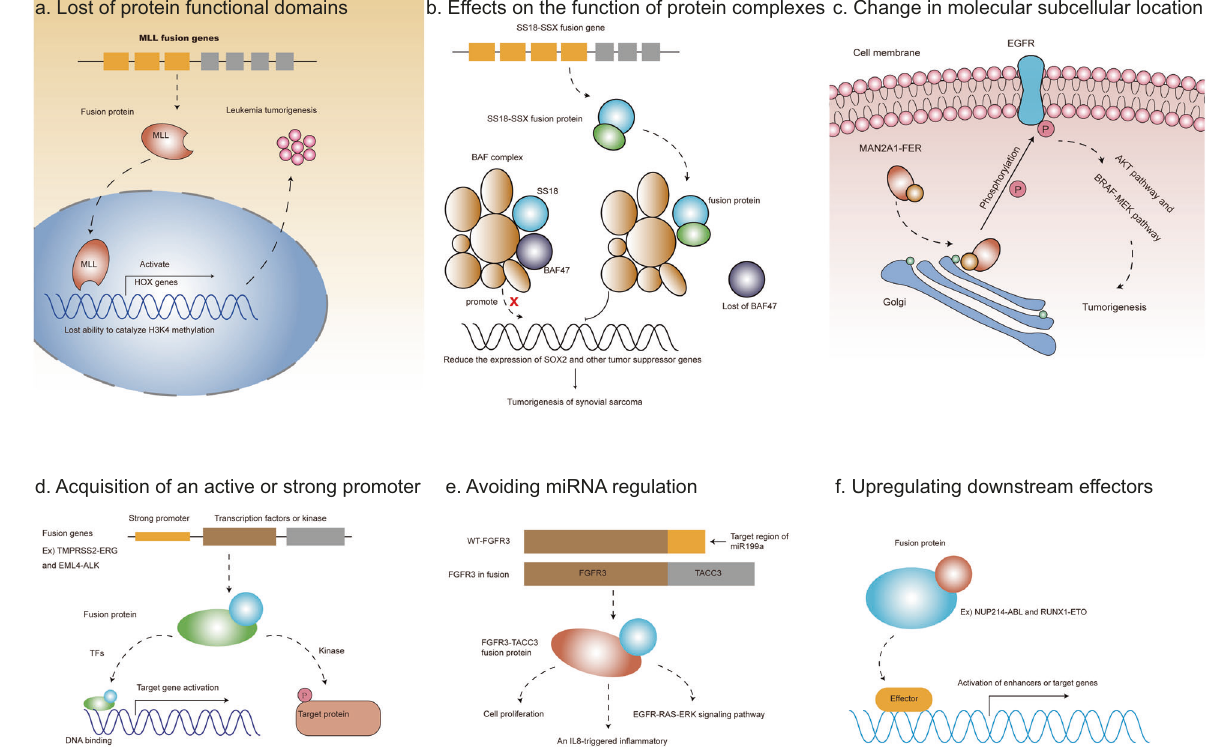
Fig. 3 General mechanism of fusion genes in cancer. MLL fusions lost its functional domain which catalyze H3K4 methylation in Leukemia tumorigenesis ( a ). SS18-SSX fusion protein cause the lost of BAF47 subunit of BAF complex in synovial sarcoma ( b ). MAN2A1-FER fusion allows the FER molecule to be located to the Golgi apparatus, thereby activating its tyrosine kinase activity ( c ). Fusion genes allow some transcription factors or kinases to acquire strong promoters, thereby activating downstream genes ( d ). FGFR3-TACC3 fusion avoids the regulation of miR199a in tumorigenesis ( e ). Some fusion proteins act as effectors to activate the target enhancers or genes ( f